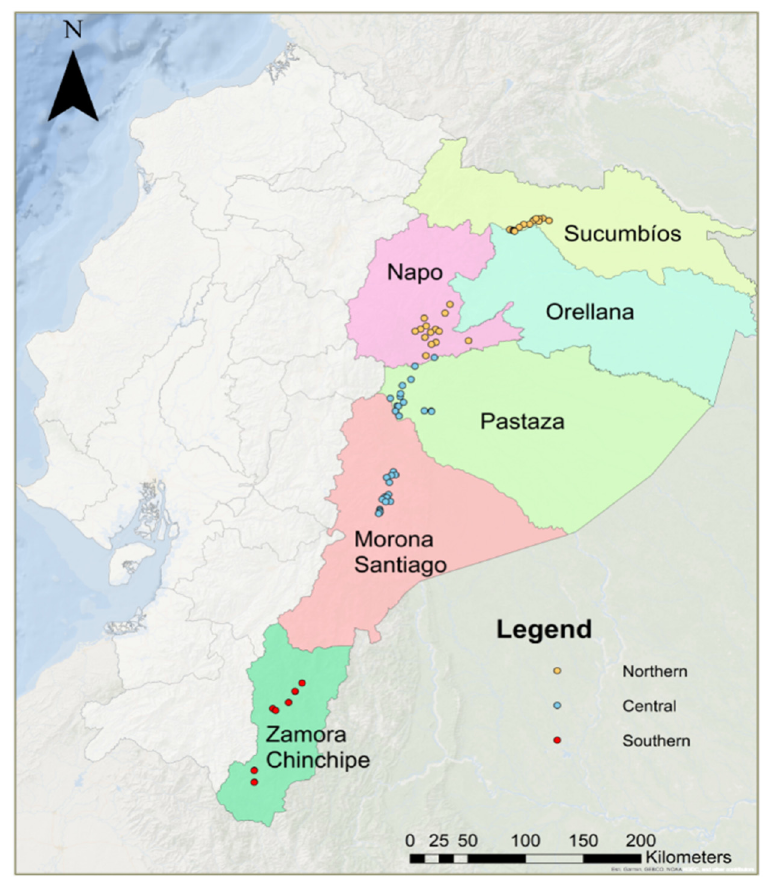
Figure 1. Map of the collection sites of Ilex guayusa individuals drawn with ArcGIS Desktop v.10.8 [29]. The Ecuadorian Amazon was divided—for the purpose of this research—into three regions: Northern, Central, and Southern, considering the samples’ latitudinal range (each region covering a latitudinal extension of 1.75 decimal degrees). Each circle represents an individual, and its color represents the region to which it belongs. The Ecuadorian Amazon provinces are labeled and highlighted in colors.